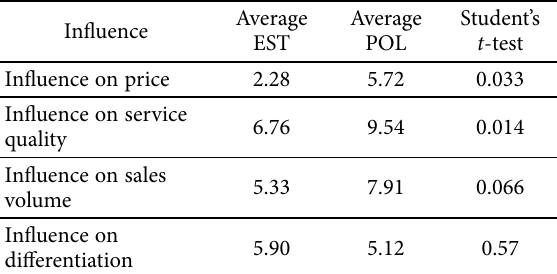
Table 8. Summarised influence of innovation in a company in Tallinn and Katowice regions